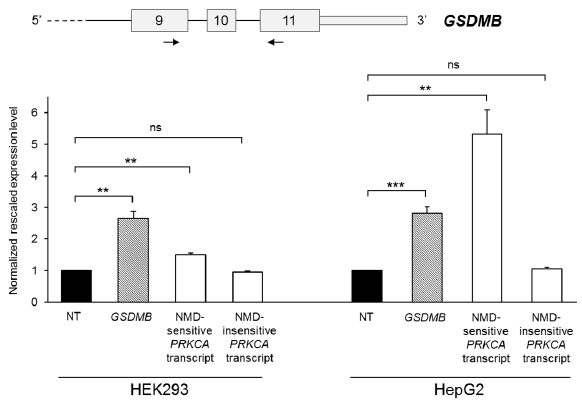
Figure 2. Evaluation of GSDMB susceptibility to nonsense-mediated mRNA decay (NMD). The upper panel shows a partial scheme of the GSDMB gene and the position of the primer couple used in the semi-quantitative real-time RT-PCR assay. The lower panel represents GSDMB total expression levels in HEK293 and HepG2 cells lines untreated (NT) or treated for 8 h with cycloheximide. Expression levels of two PRKCA transcripts, sensitive and insensitive to NMD, are also shown. The expression level of the untreated sample was set to 1. Bars represent means + SEM (standard error of the mean) of three independent experiments, each performed in triplicate. Significance levels of t -tests are shown. ** p < 0.01; *** p < 0.001; ns: not significant.